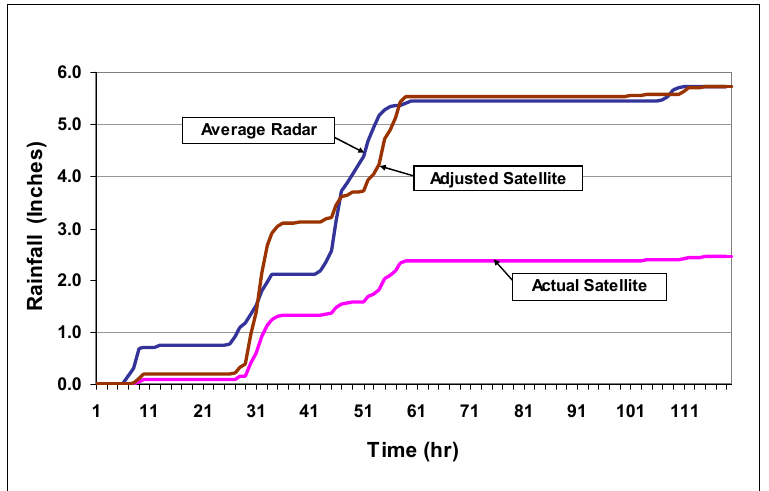
Figure 6. Cumulative satellite rainfall hyetographs for deriving bias adjustment. Table 2. Streamflow error statistics using actual (unadjusted) satellite rainfall d